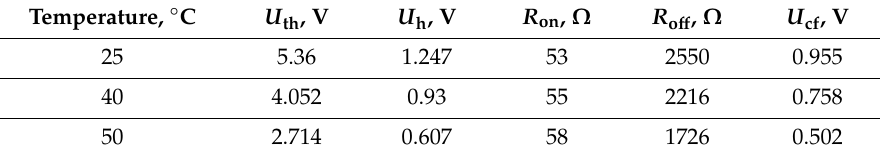
Table 1. Temperature dependences of the threshold parameters of the I–V characteristic.